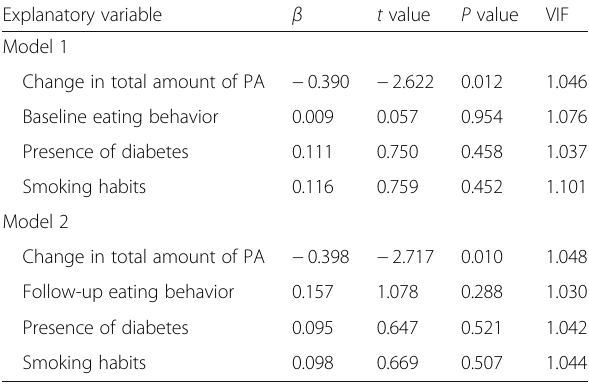
Table 3 Stepwise multiple regression analysis using body weight change as the objective